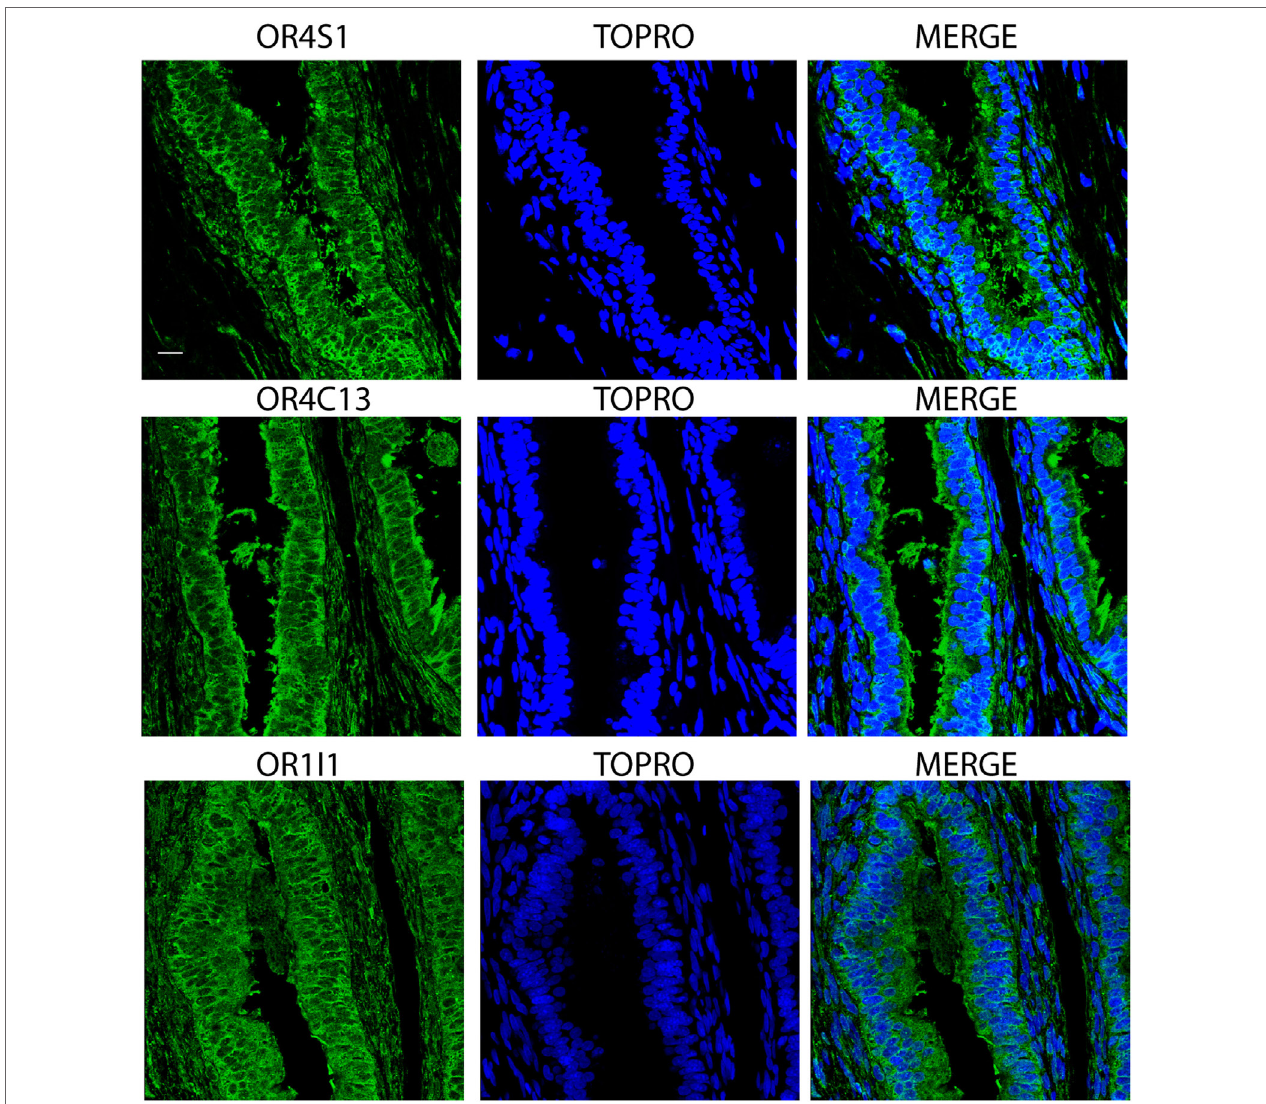
FigUre 5 | Confocal analysis of OR4S1, OR4C13, and OR1I1 expression in the pseudostratified columnar epithelium of the epididymis. Nuclei were counterstained with TOPRO. Scale bar 25